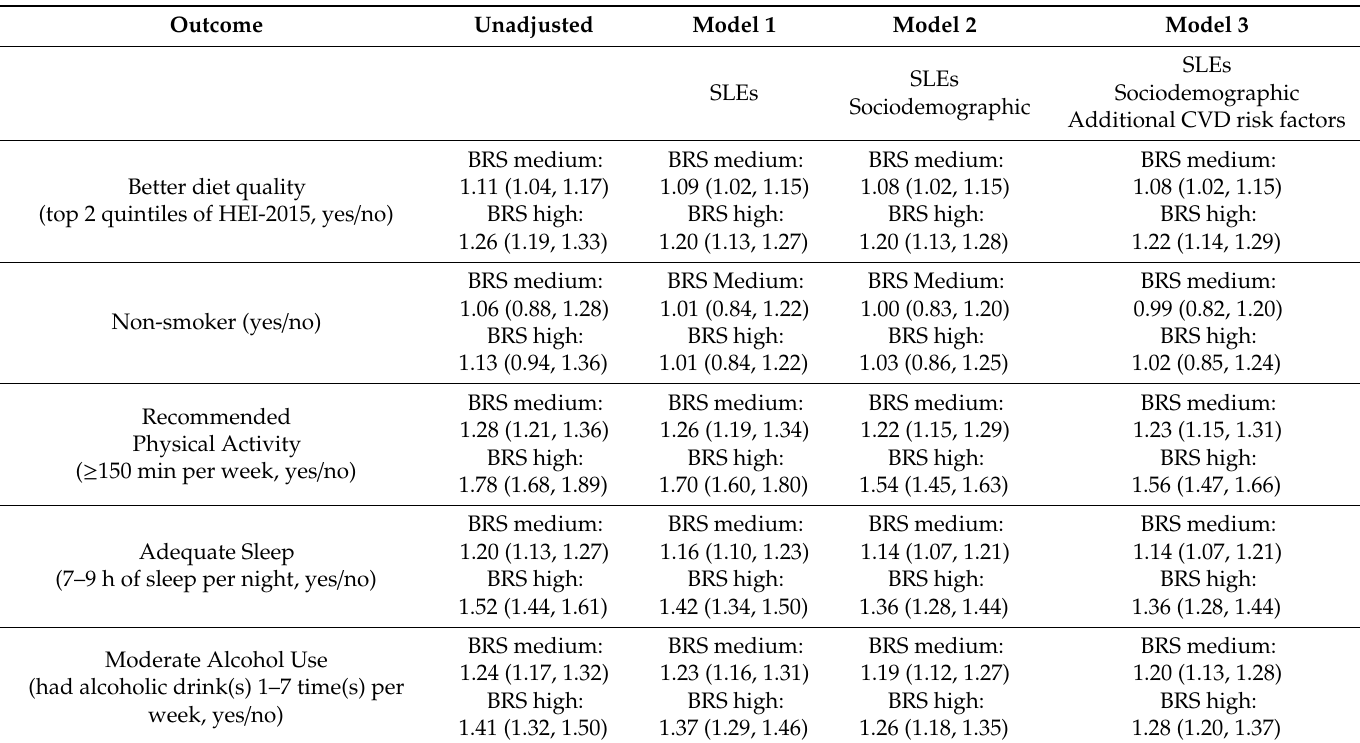
Table 3. Estimated associations between self-reported psychological resilience and CVD-protective health behaviors, adjusted for stressful life events (SLEs), sociodemographic information (age, race / ethnicity, and education), and additional CVD-protective risk factors (BMI, diabetes, hypertension, and dyslipidemia). Low BRS was designated as the reference group for all models. Each cell contains the estimated odds ratio (95% confidence